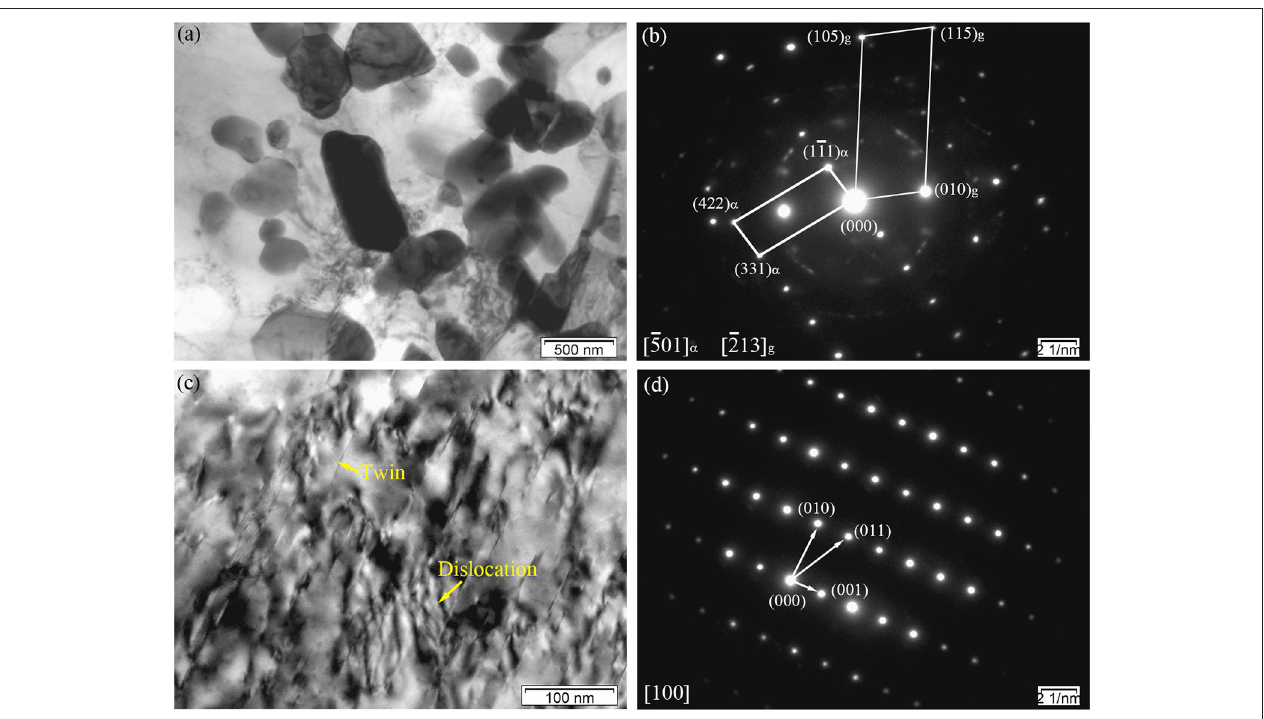
FIGURE 6 | Microstructure of the E330 sample: (a,c) BF images; (b) Corresponding SAED pattern of (a) ; (d) Corresponding SAED pattern of (c)